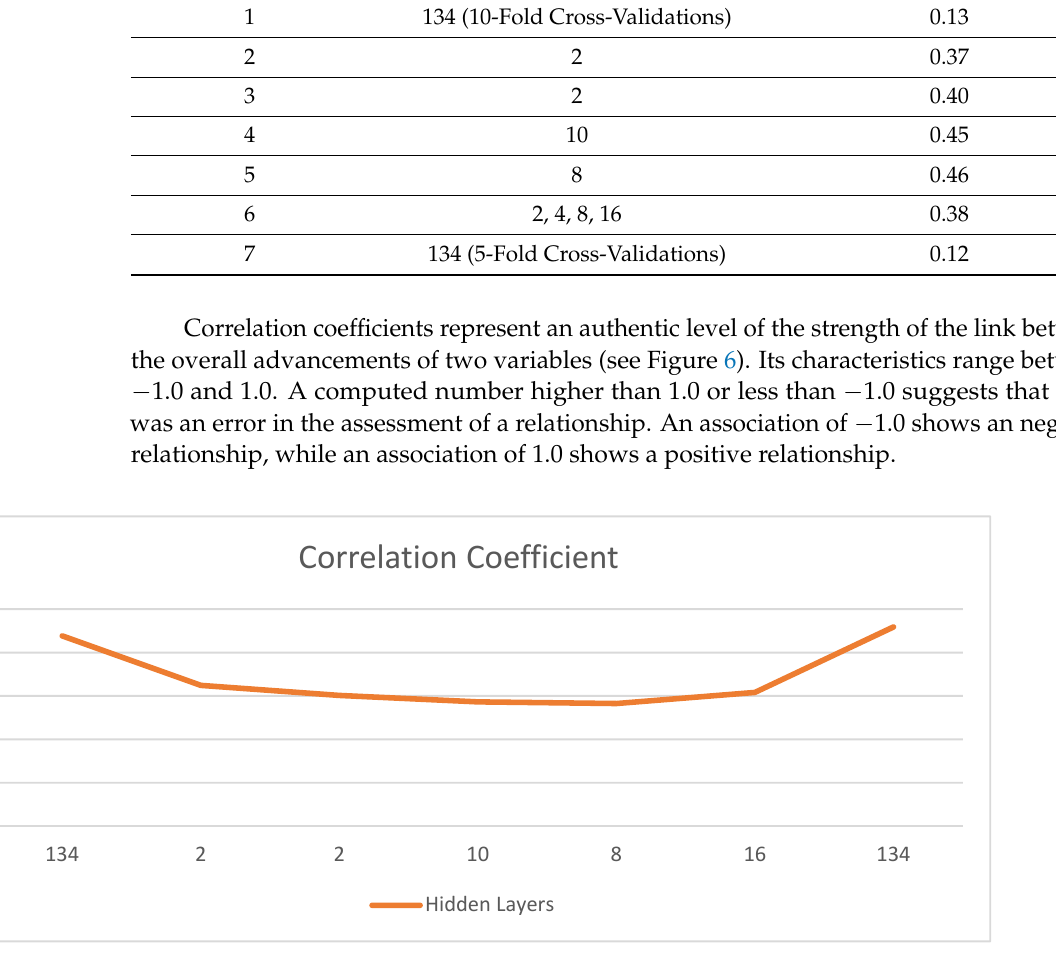
Table 2. The root mean square error (RMSE).